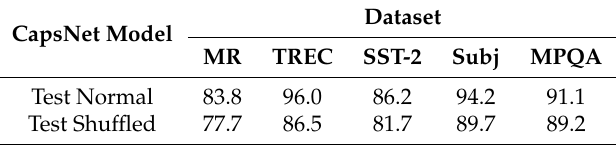
Table 3. Accuracy of the proposed CapsNet model on different datasets.